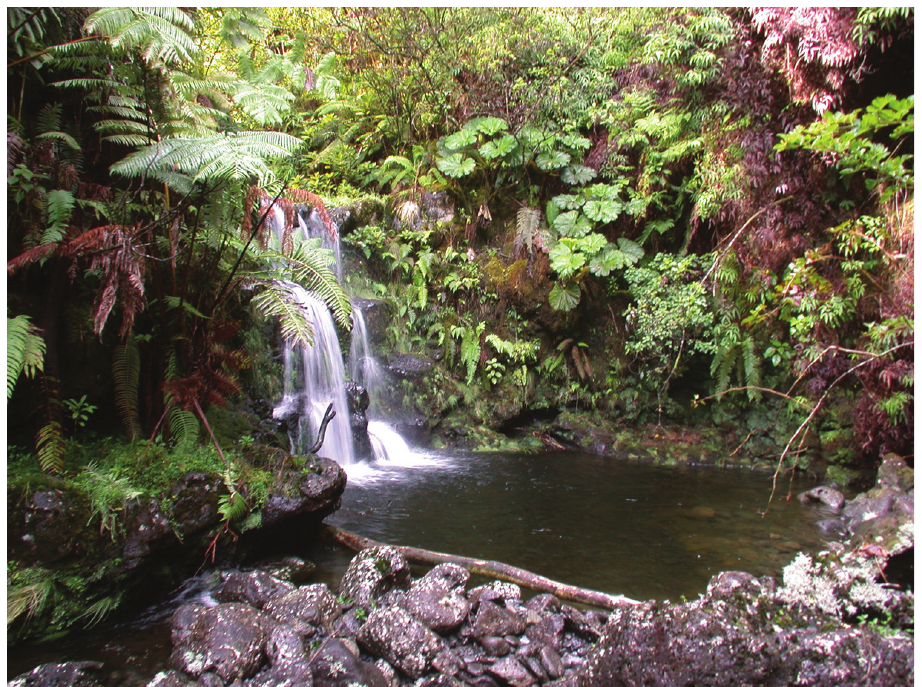
Figure 3. Typical habitat of Athyrium haleakalae around stream plunge pools, Hana Forest Reserve, East Maui, HI. Photo by K.R. Wood, 21 Aug